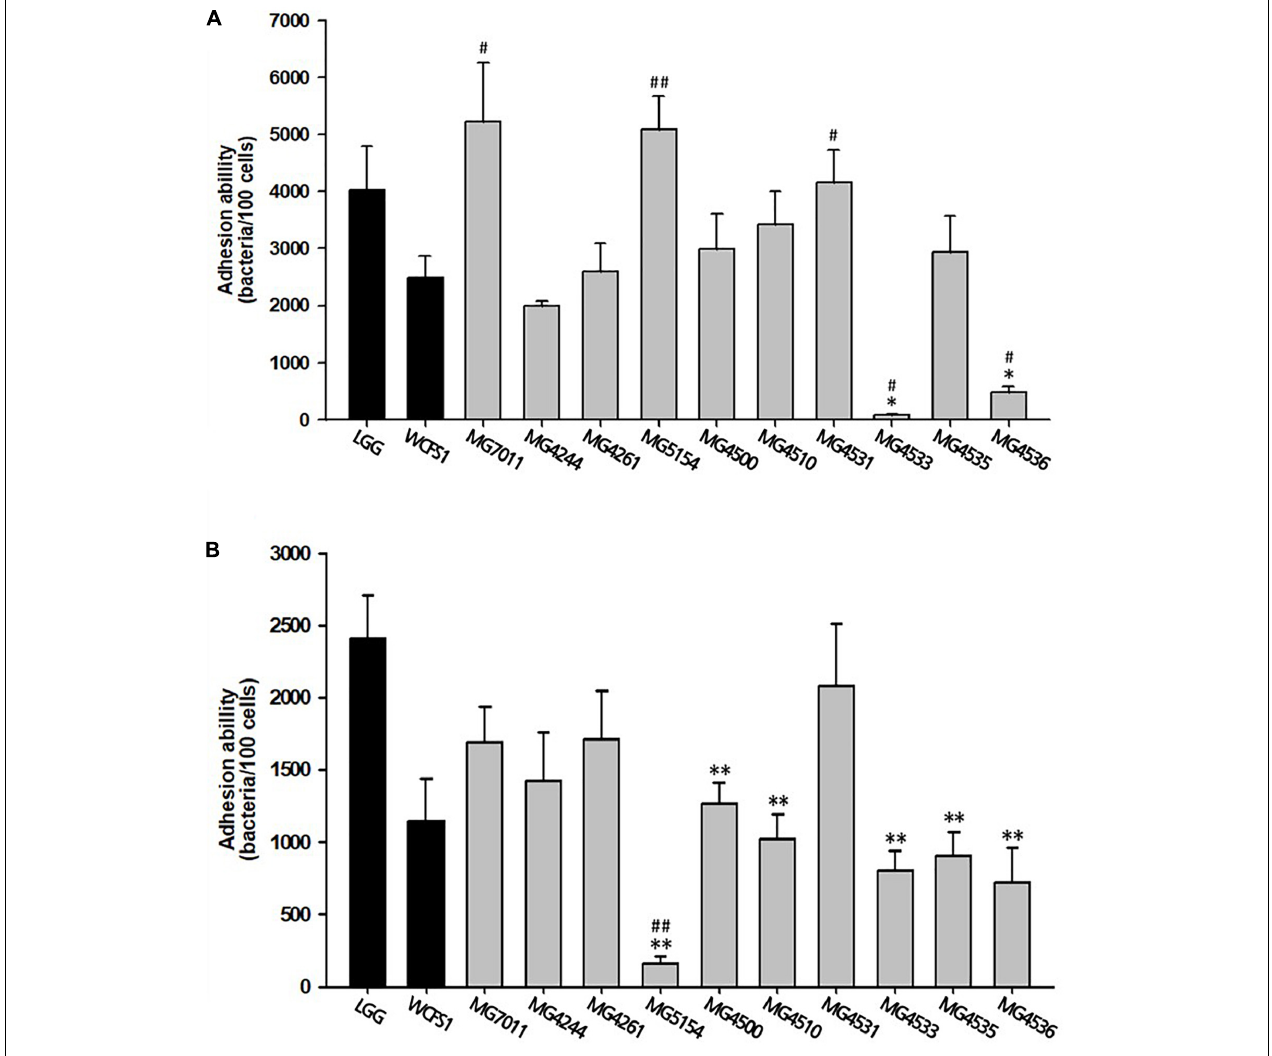
FIGURE 1 | Intestinal adhesion ability of Limosilactobacillus fermentum strains. (A) Caco-2 cells, (B) HT-29 cells as colonic epithelial cells. Data are the mean ± SD ( n = 3). ∗ p < 0.05, ∗∗ p < 0.01 compared with control strain WCFS1 and # p < 0.05, ## p < 0.01 compared with the control strain